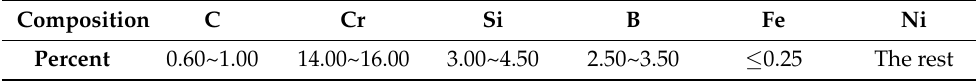
Table 2. Chemical compositions of the Ni60A substrate